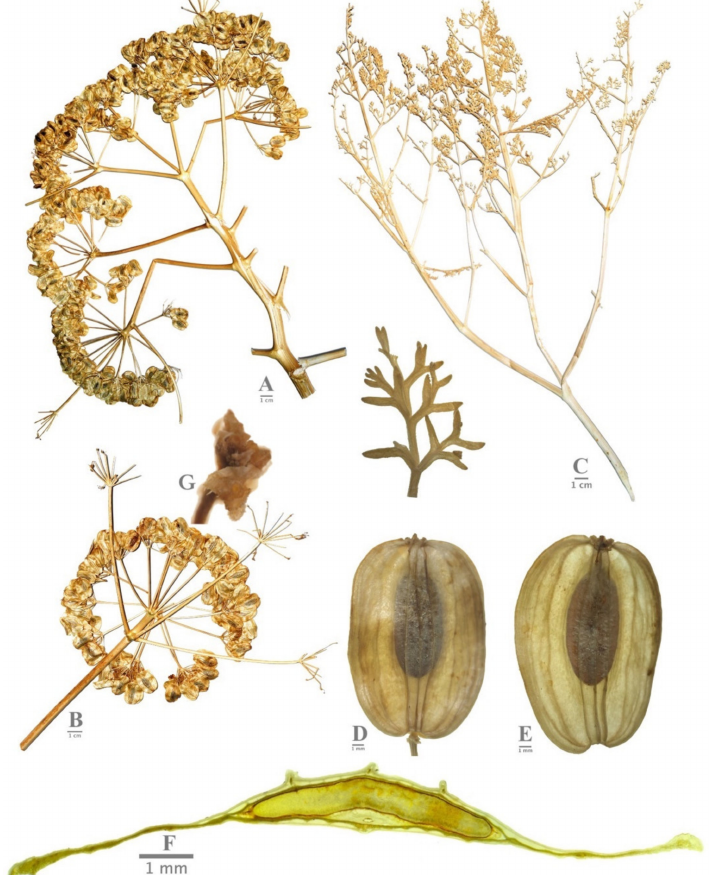
Figure 4. ( A , B ) General view of Ferula latialata umbella. ( C ) Basal leaf of F. latialata . ( D , E ) General view of F. latialata fruits. ( F ) Cross-section of mericarp of F. latialata . ( G ) Petals with setulose-puberulent